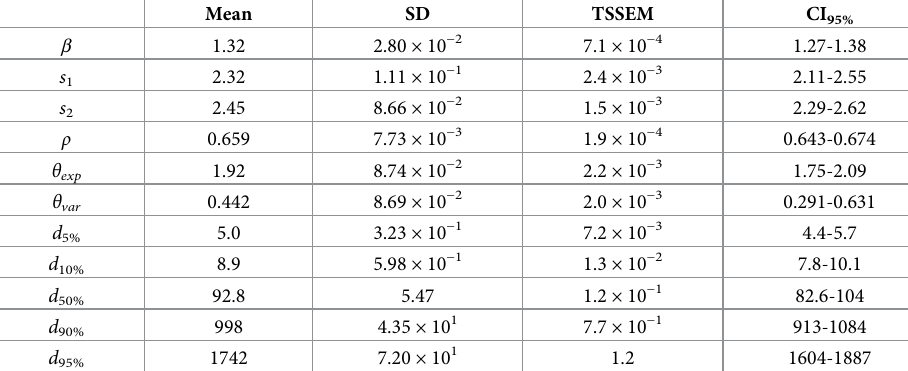
Table 3. Summary statistics for parameters estimated from the survey